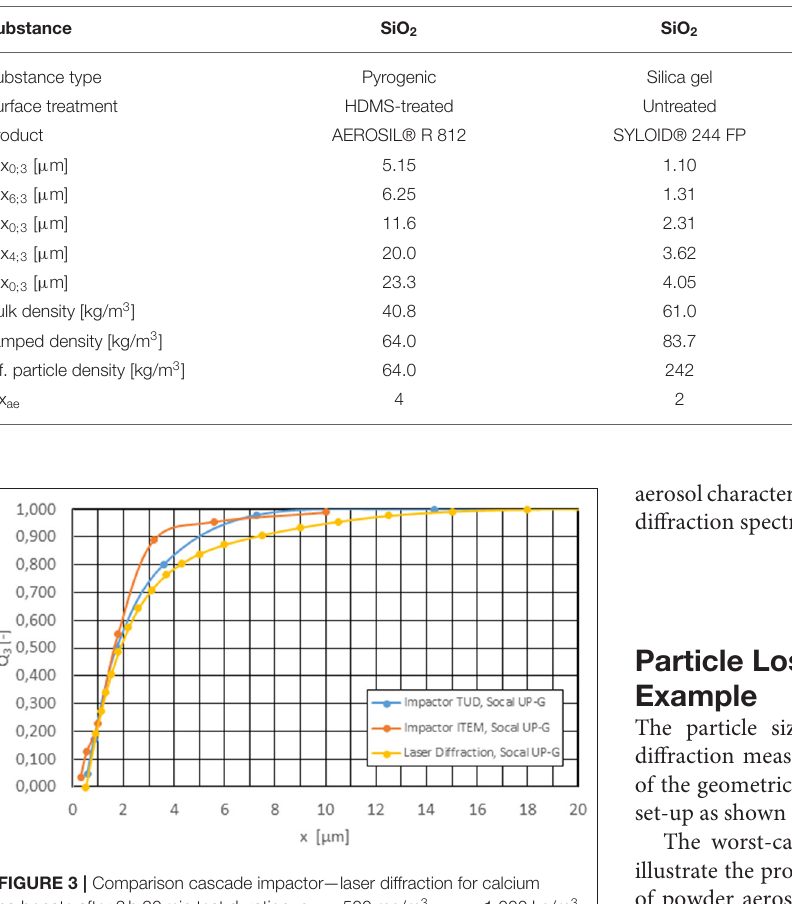
estimated from the tap density of 447 kg/m 3 at an assumed bulk porosity, the substance not tending to agglomerate, of